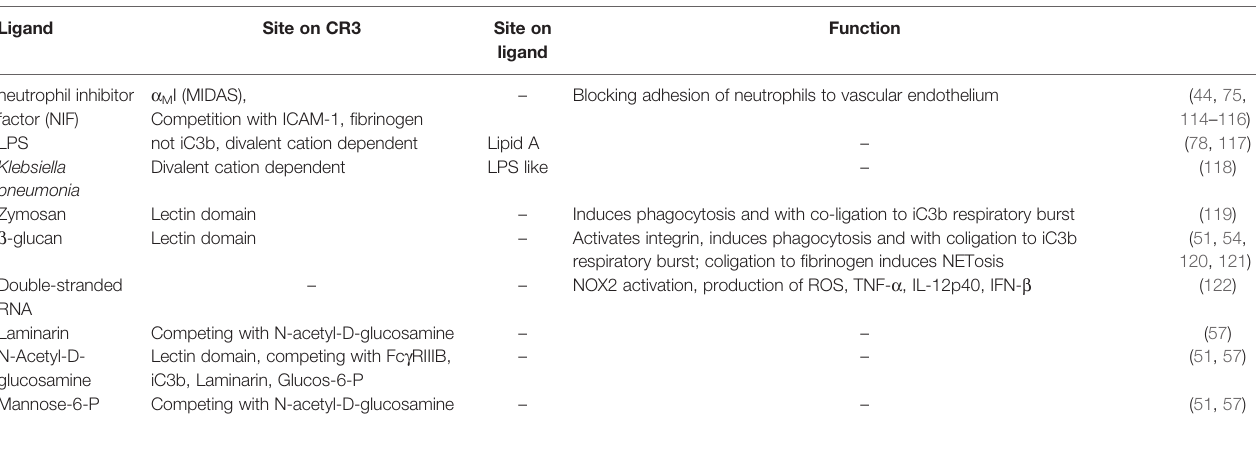
TABLE 2 | Defense against